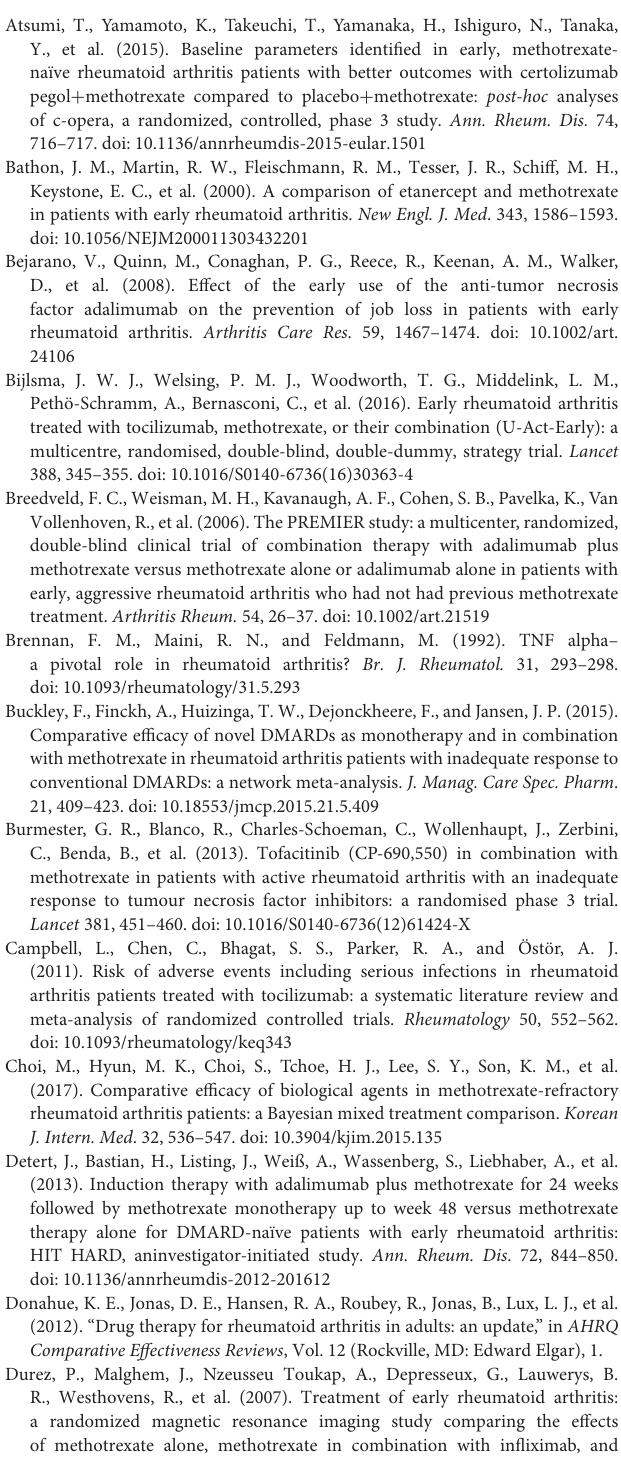
Figure S5 | The results of consistency analysis by note-splitting plot and heat plot of adverse events.